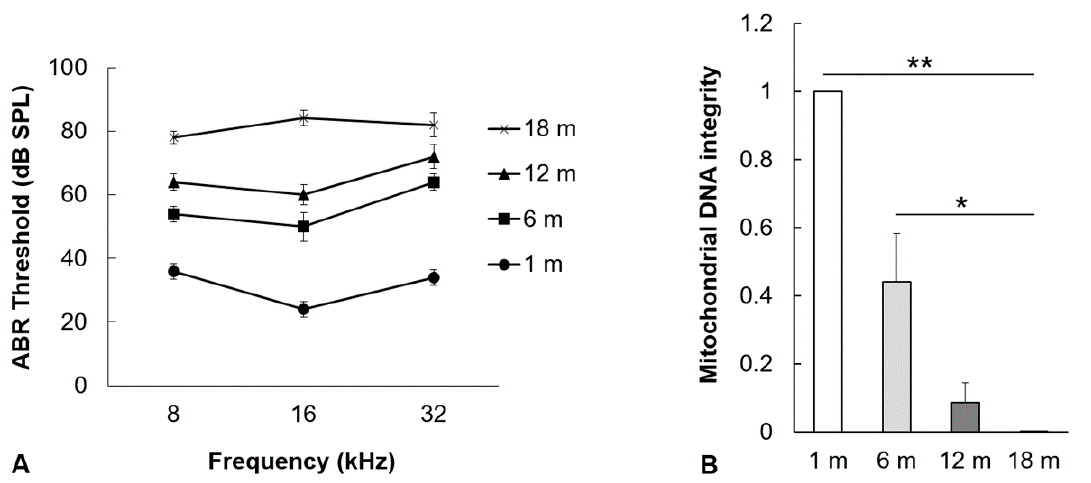
Figure 1. The effect of aging on auditory brainstem response (ABR) thresholds and mitochondrial DNA (mtDNA) integrity. ( A ) The hearing thresholds of mice at frequencies of 8 kHz, 16 kHz, and 32 kHz increased with aging (fifteen mice per group). ( B ) The mtDNA integrity was assessed by measuring the expression level of 10 kb amplicon. The mtDNA integrity in the mouse auditory cortex significantly decreased with aging. The data are shown as mean ± standard error of mean (five mice per group; 1 m, 1 month; 6 m, 6 months; 12 m, 12 months; 18 m, 18 months; SPL, sound pressure level). * p < 0.05, ** p < 0.01.